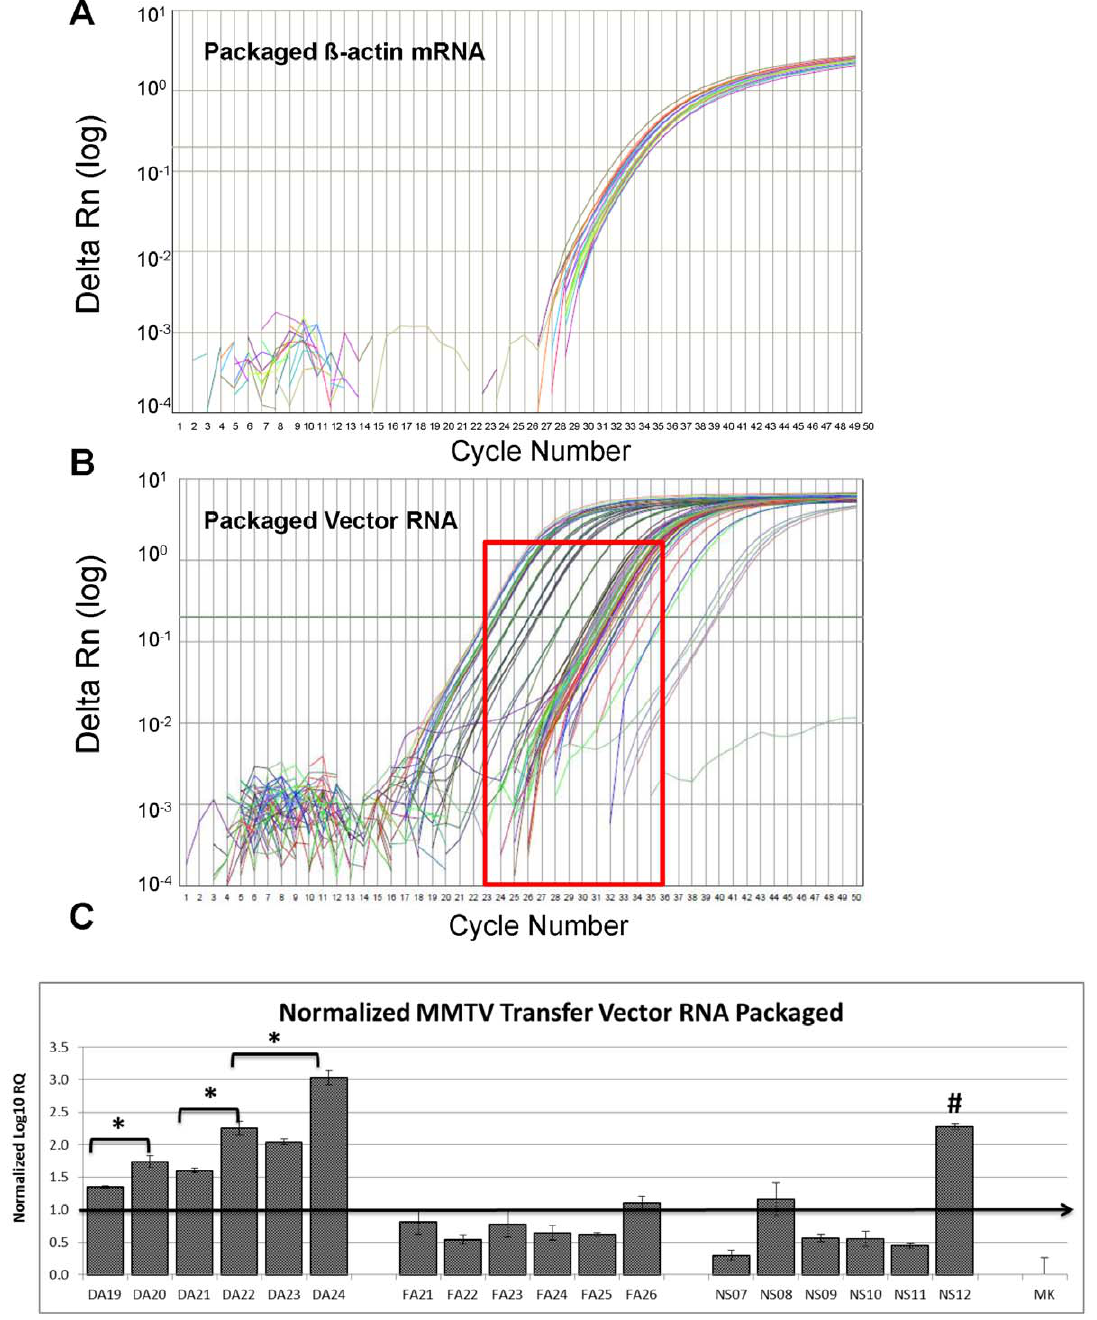
Figure 5. Relative packaging efficiency of MMTV transfer vector RNAs into the pseudotyped MMTV particles. Real time PCR analysis of ( A ) packaged b -actin RNA into VSV-G-Env-pseudotyped MMTV particles and ( B ) packaged transfer vector RNAs into the VSV-G-Env-pseudotyped MMTV particles expressed as D Rn verses cycle number. D Rn is the target gene-specific fluorescence signal (FAM for MMTV-specific and VIC for ß- actin-specific sequences) normalized to the signal for the internal passive control, ROX (Normalized Reporter or Rn) from which the baseline target fluorescence has been subtracted ( D Rn=Normalized Reporter (Rn) - baseline). ( C ) Relative RNA packaging efficiencies for each of the mutant transfer vector RNA after normalization with b -actin and luciferase expression. The box in panel B highlights the wide range of threshold cycle (Ct) values observed for each transfer vector in comparison to the similar amounts of b -actin packaged into the viral particles. The arrow in panel C highlights the threshold value of detection. MK, Mock, cells transfected with packaging construct, JA10 + the VSV-G-Env expression plasmid, MD.G + luciferase- expression vector, pGL3 except the transfer vector. RQ, Relative Quantification in log 10 units. *, statistically significant differences between constructs are shown by the brackets (p , 0.01). # , statistically significant difference between NS12 and DA24 (p , 0.01). The primers/probe for detecting the transfer vectors were designed within the U5 region of the MMTV LTR, a region common to all transfer vector RNAs. Each sample was tested in triplicates with MMTV- and b -actin-specific probes and primers in panel B, while the b -actin samples shown in panel A were tested in duplicates, as described in Materials and Methods.